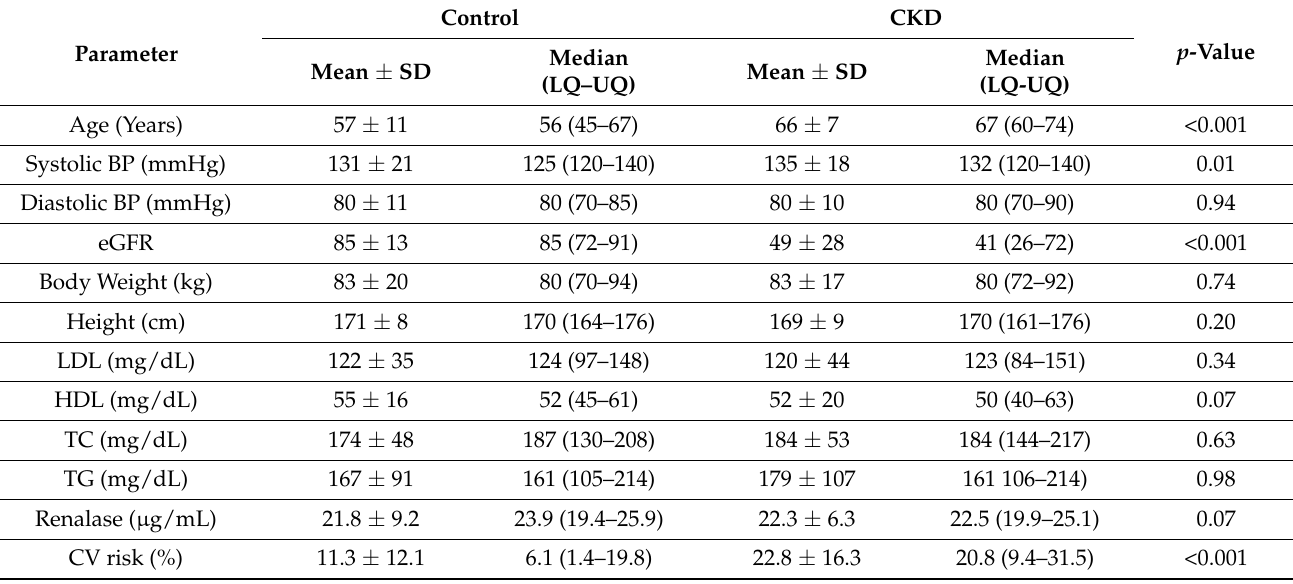
Table 3. Demographic and descriptive data and statistical evaluation between control and the whole CKD group (Mann– Whitney U test).